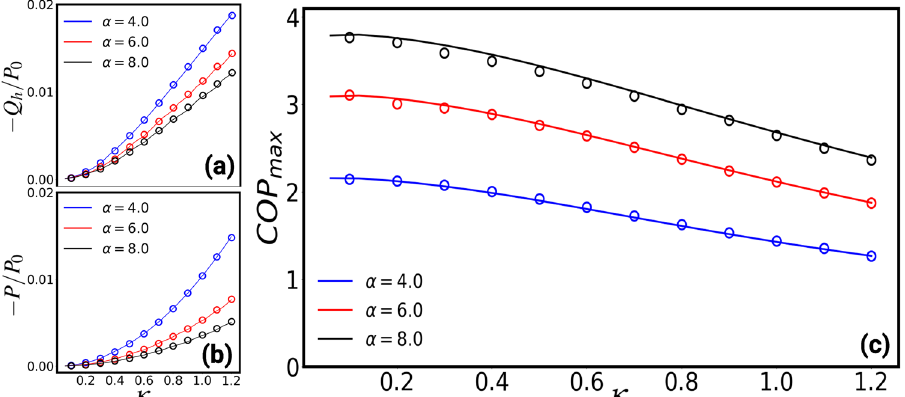
Figure 5. ( a ) and ( b ) present the average rate of the heat absorbed by the hot bath and the corresponding input work for a magneto-refrigerator operating at maximum COP with T h / T c = 1.1 and M = 1.0 as a function of the diffusive Hall parameter parameter κ for different values of α where P 0 = k ( T c + T h )/γ . Note that the work done on the system is negative giving rise to a negative heat flux. ( c ) shows the maximum of the COP of the corresponding system. The solid lines depict the theoretical predictions and the symbols show the simulation results. The maximum COP is larger than unity for a range of κ shown in this